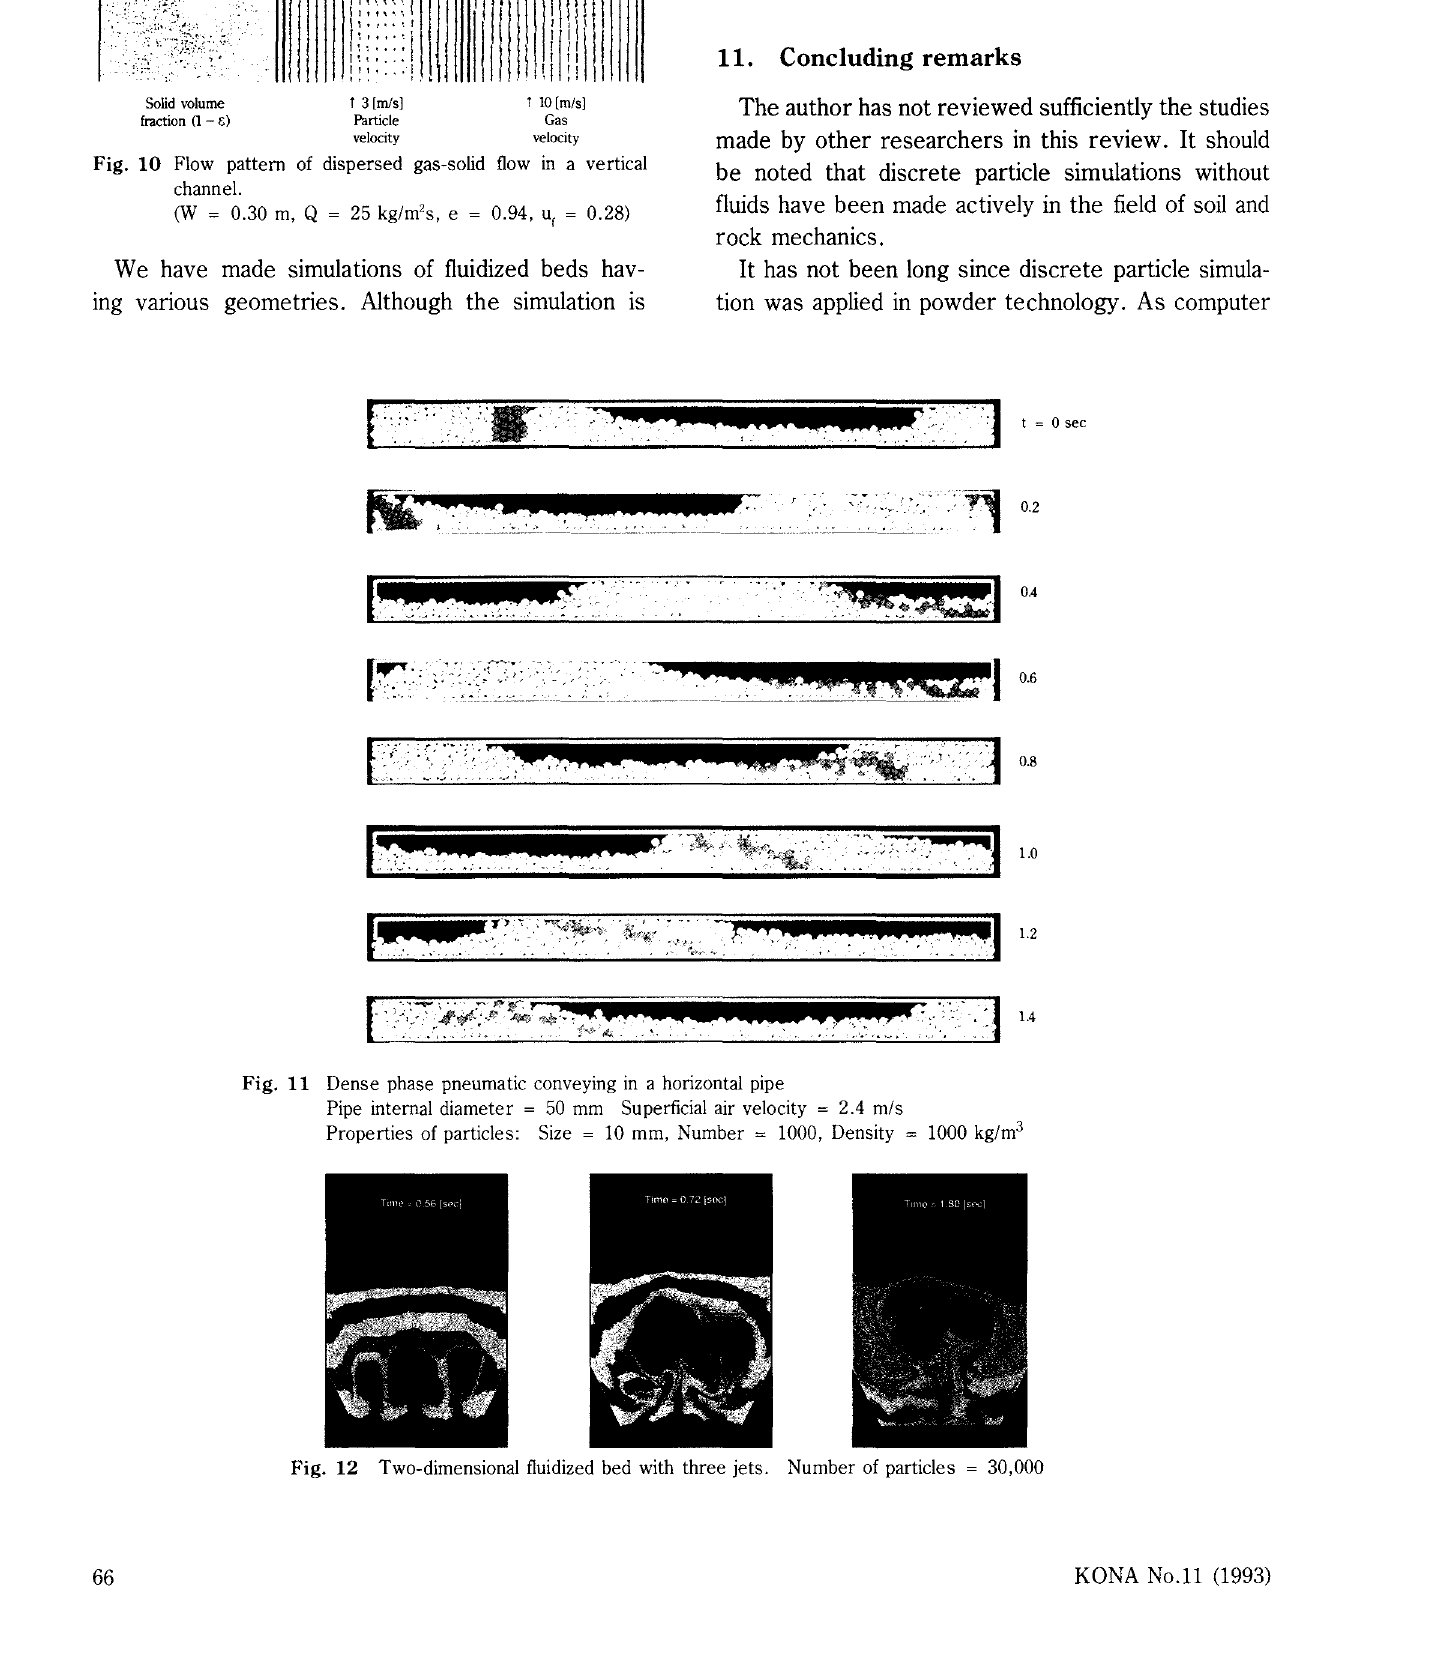
Fig. 12 Two-dimensional fluidized bed with three jets. Number of particles ;